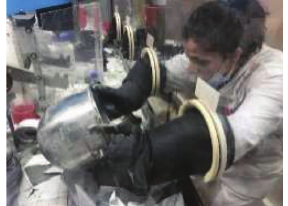
Fig. 20. Cementing of incinerator ash.